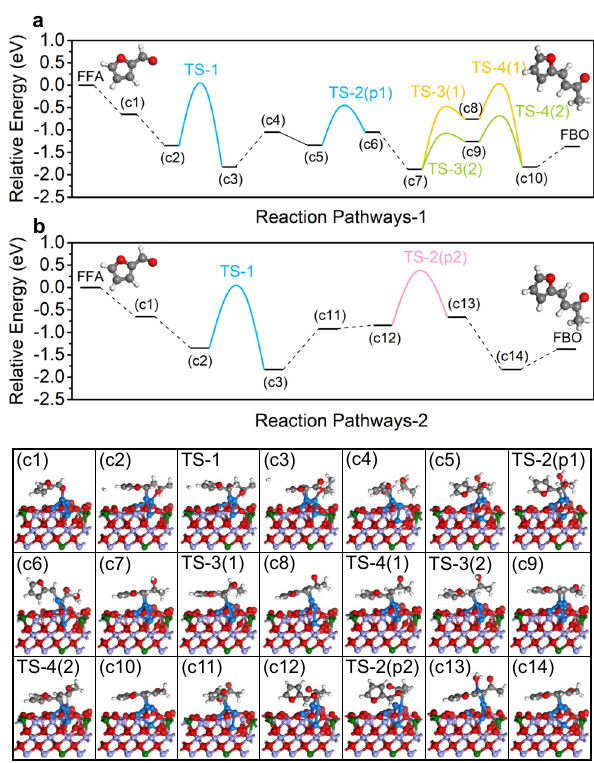
Fig. 6 The plausible reaction mechanism over Cu 4 /Fe 0.3 Mo 0.7 O 2 @C. a , b The free energy diagram for oxidative coupling of FFA with IPA, and c 1 – c 14 the simpli fi ed surface structures of various reaction species along the reaction pathway on Cu 4 /Fe 0.3 Mo 0.7 O 2 @C. Cu (blue), Fe (green), Mo (purple), O (red), C (gray), and H (white). “ TS ” denotes a transition